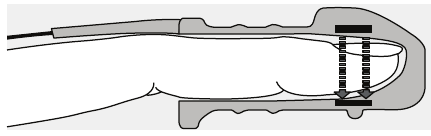
Figure 3: Probe oximetry